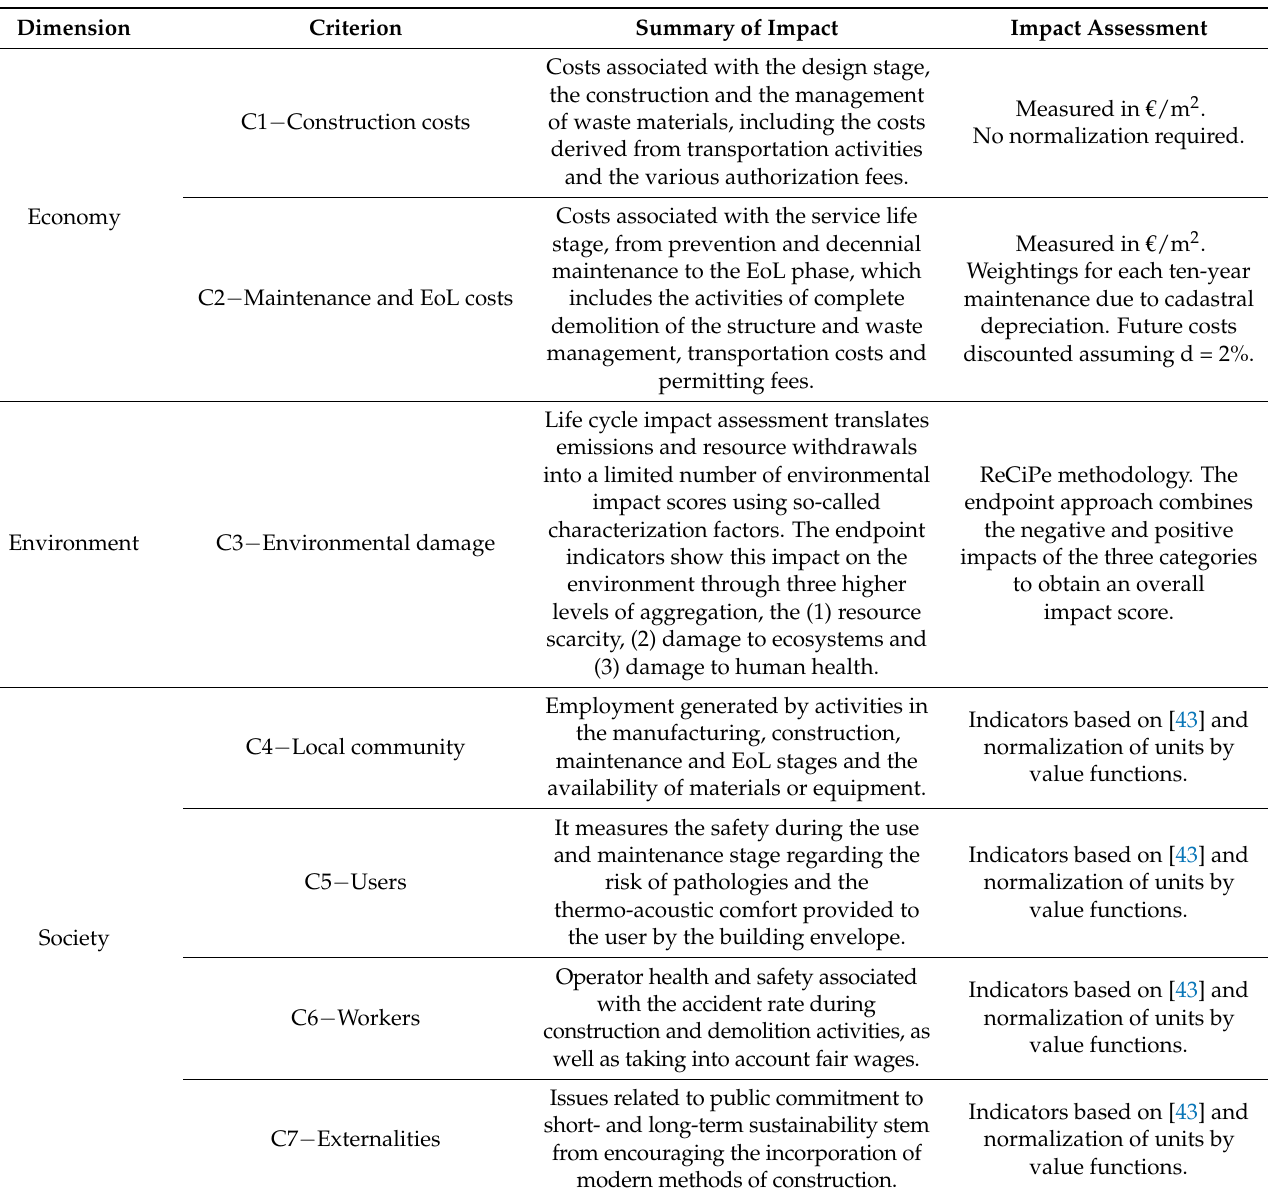
Table 3. Sustainability criteria relevant to a single-family housing